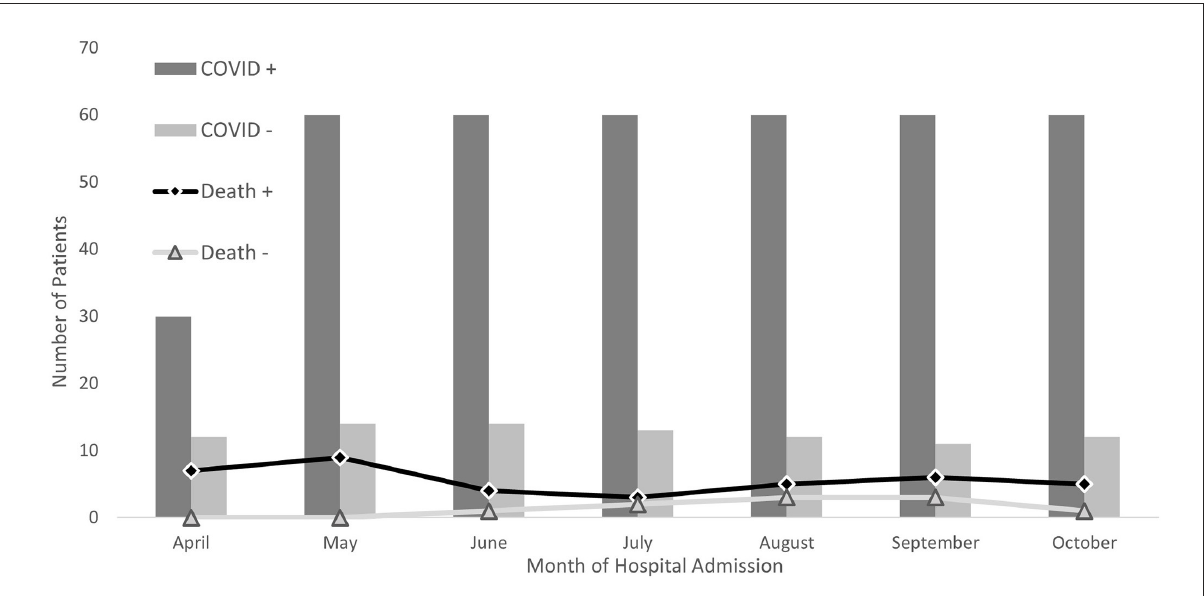
FIGURE2 Hospital admissions and death by SARS-CoV-2 status among patients at Nebraska Medicine Between April and October 2020, Omaha,